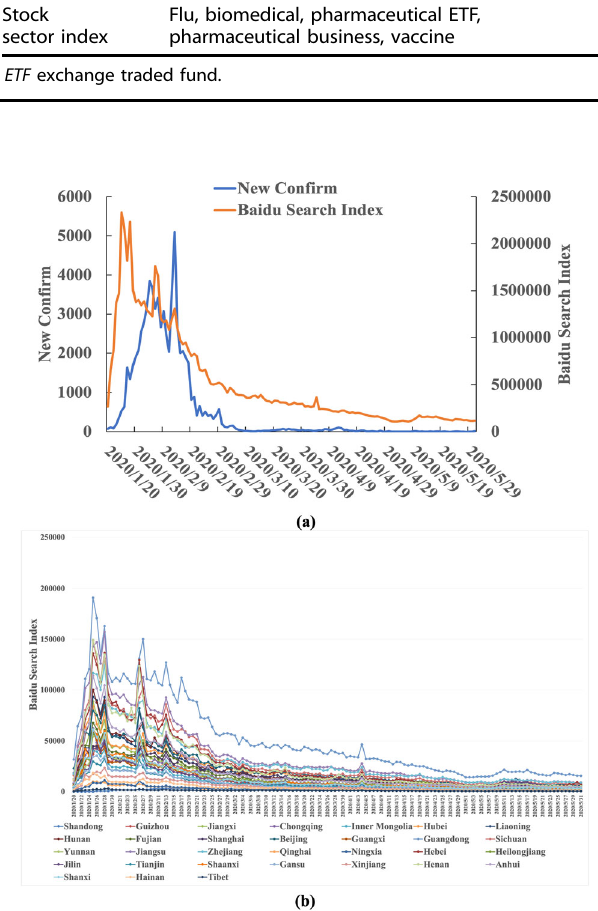
Fig. 8 Baidu index and time series distribution of daily new cases. a Shows the overall situation of the whole country, and b shows the situation of each